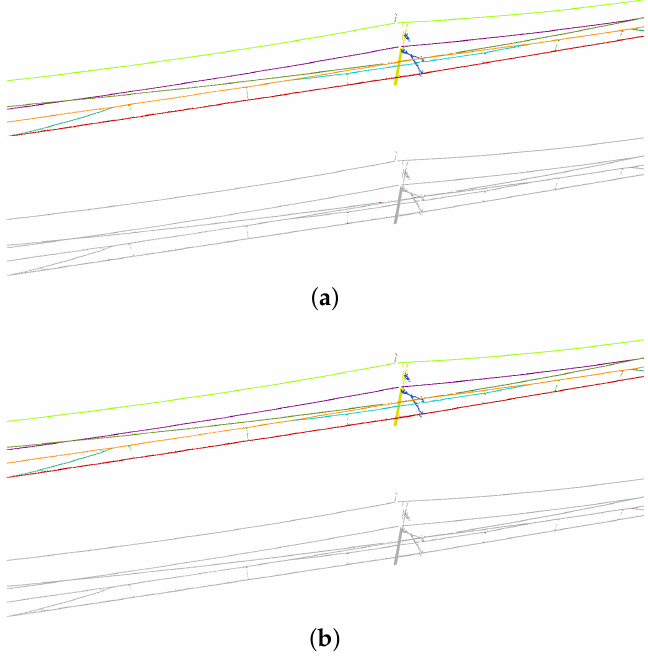
Figure 9. Segmentation results of non-insulated overlap section: ( a ) unidirectional mode; and ( b ) bidirectional mode. In each subfigure, predictions are shown above and errors are highlighted in red below (the same as Figures 10 and 11.)